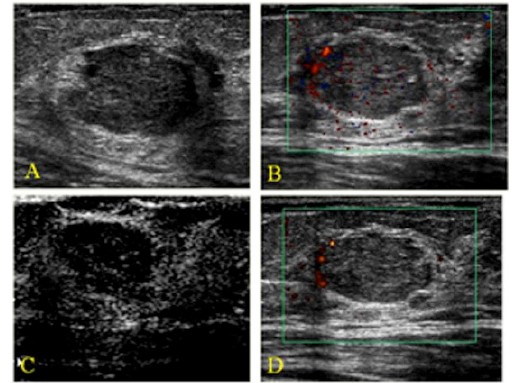
Figure 3 - An invasive ductal carcinoma in the right breast of a 71-year-old woman. A) A gray-scale image showing an irregular, microlobulated mass with an echogenic halo and acoustic shadowing (BI-RADS not 3). B) A color Doppler image showing a hypervascular lesion with central and irregular arteries. C) After contrast injection, there was intense enhancement. D) An enhanced color Doppler image showed the same pattern as the unenhanced CDUS. Power Doppler imaging was used only to produce clearer images for illustration